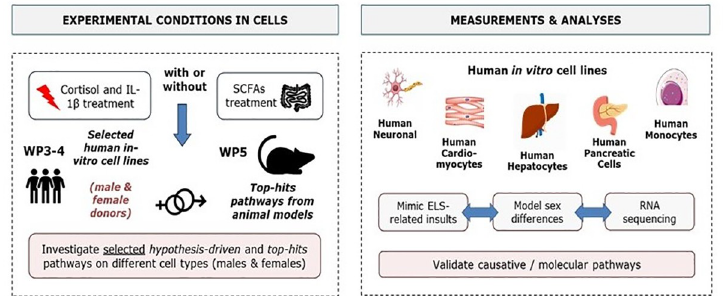
Fig 5. Overview of the cellular modelling experiences. SCFAs (Short-chain fatty acids).